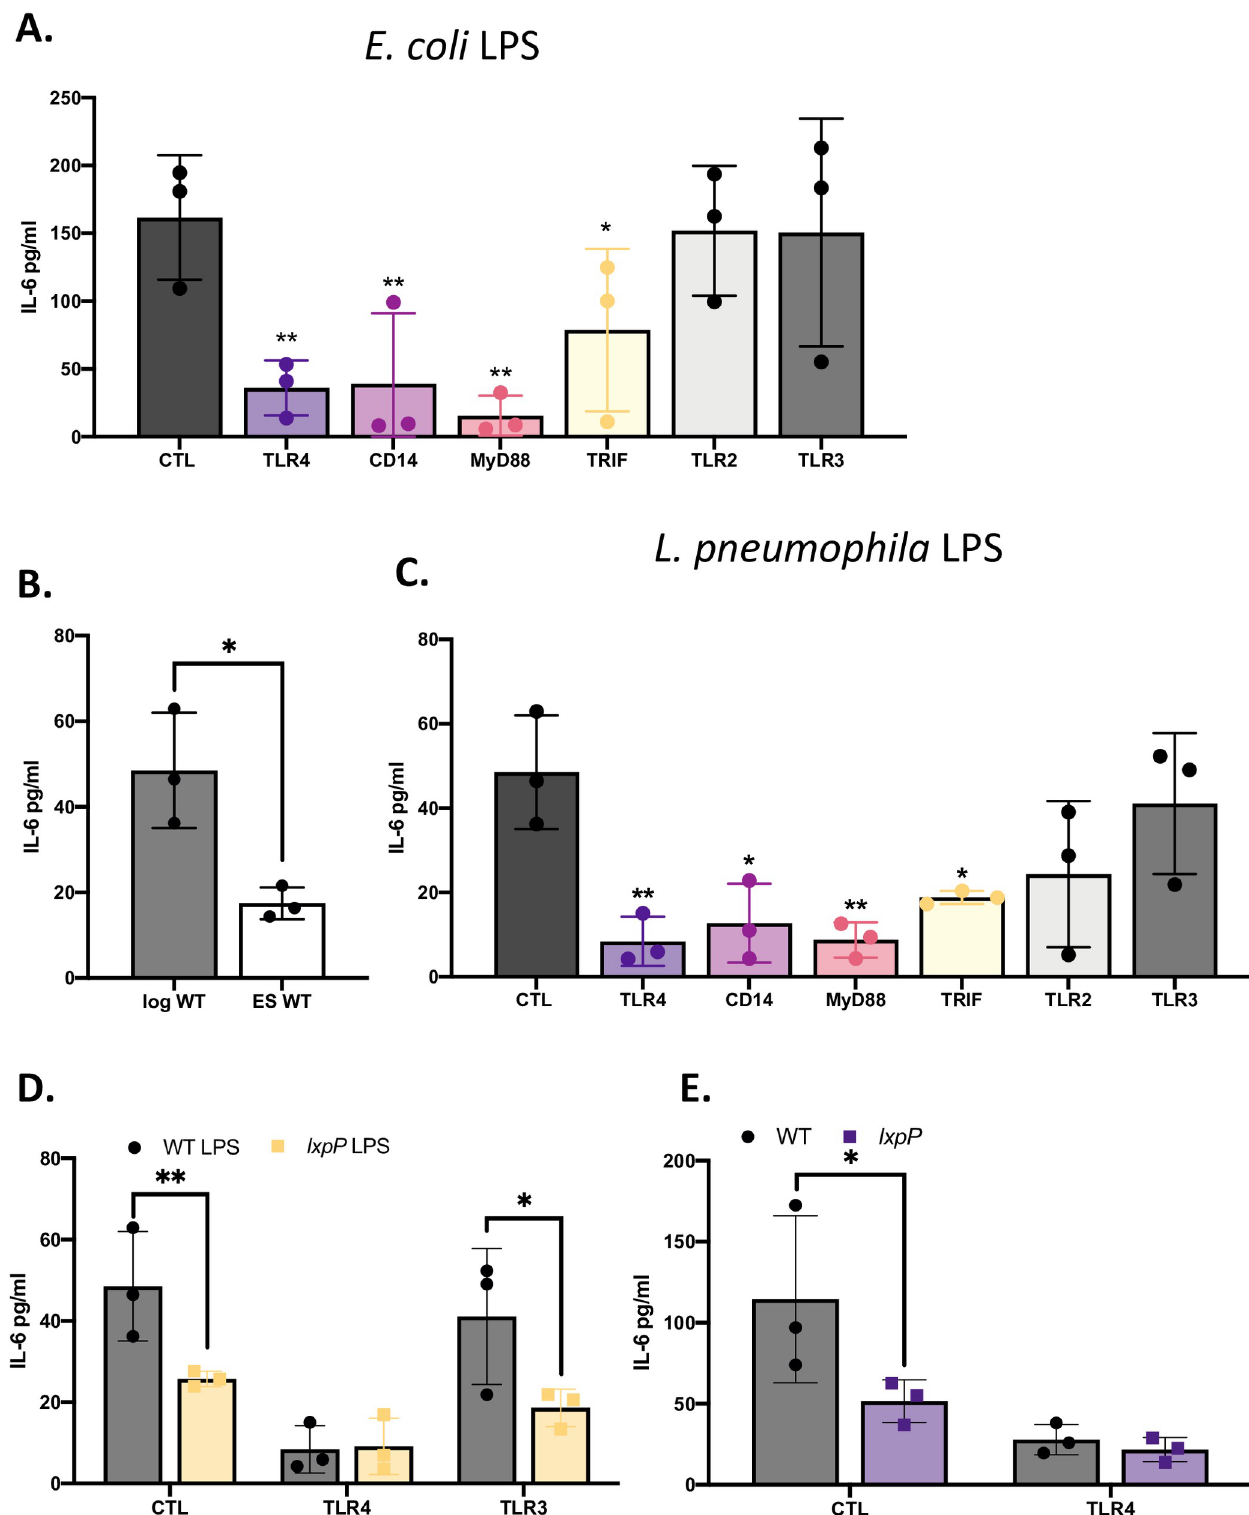
Fig 10. Effect of the TLR4 signaling pathway on the response of human macrophages to L . pneumophila wildtype and mutant LPS. (A) U937 macrophages expressing a non-targeting CRISPR guide plasmid (CTL) and U937 cells containing a CRISPR-generated KO of either TLR4, CD14, MyD88,